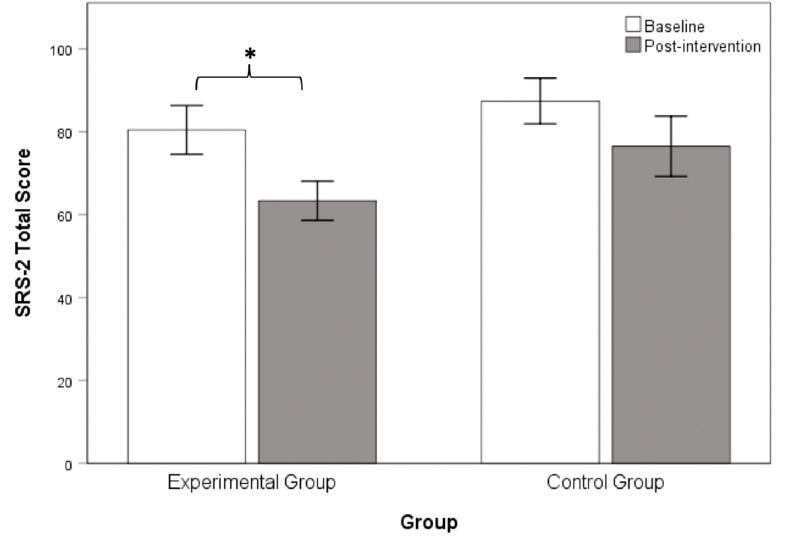
Figure 3. Mean parental rating on children’s socialization ability in the experimental and control groups before and after intervention. Children from the experimental group are rated to have reduced social communication problems after intervention, whereas those in the control group were not. SRS-2 = Social Responsiveness Scale, 2nd edition (comprising measures of social communication ability and restricted and repetitive behavior). * p < 0.01 in paired samples t -test. Error bars represent 1 standard error ± mean.